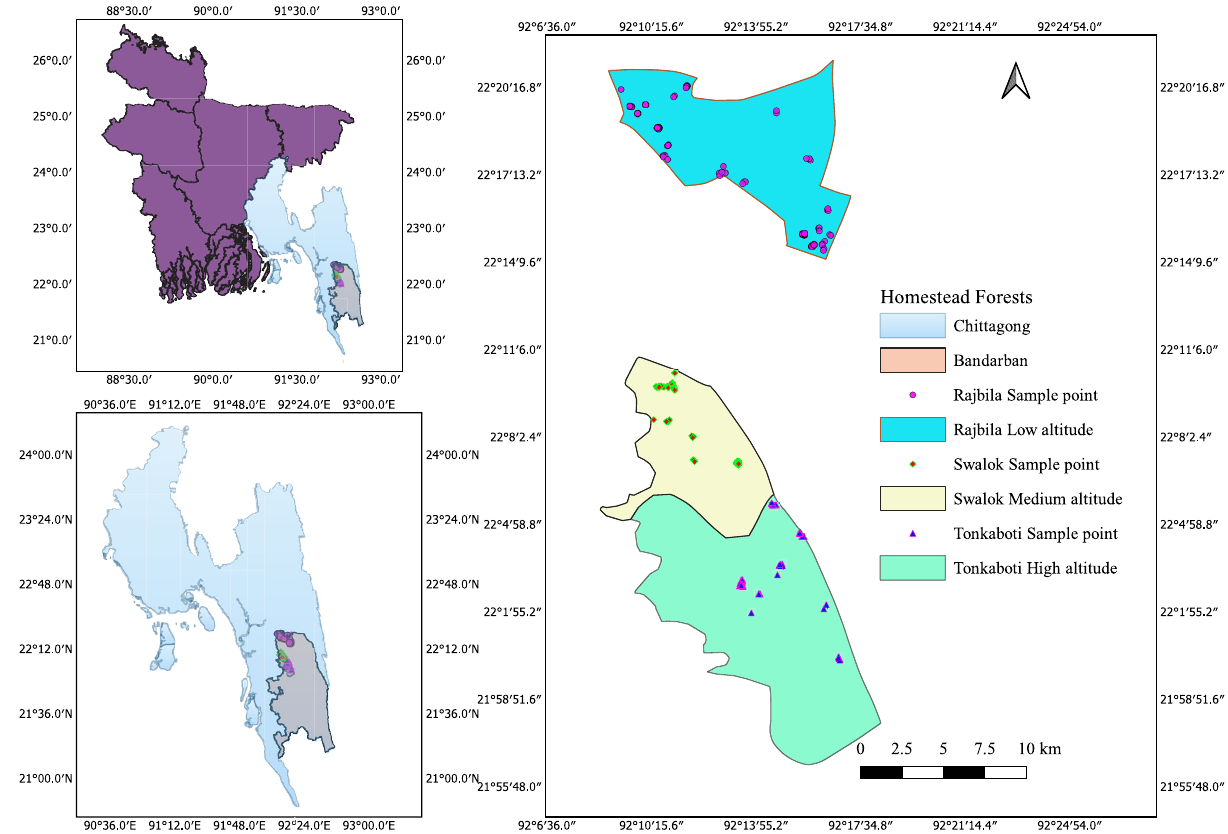
Figure 5. Map of the study area with sampling points of homestead forests. The Maps are created using the Free and Open Source QGIS 3.1 0, http:// www. qgis.